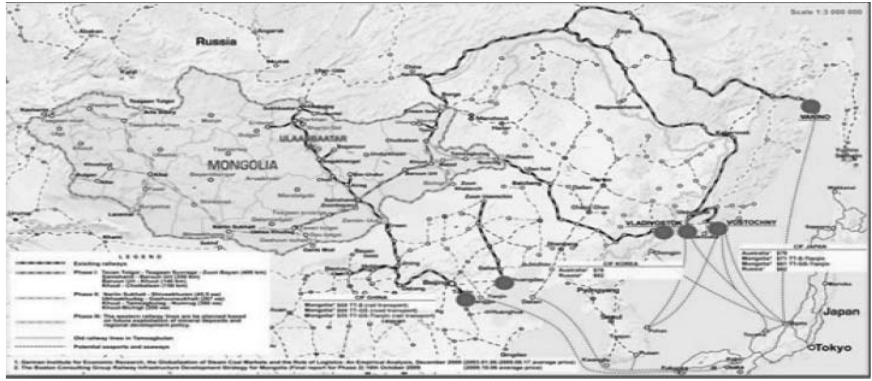
Figure 1. (Mongolia transit corridors and access to seaport) In the Northern Asia, there are two major road traf fi c lines linking Asia and